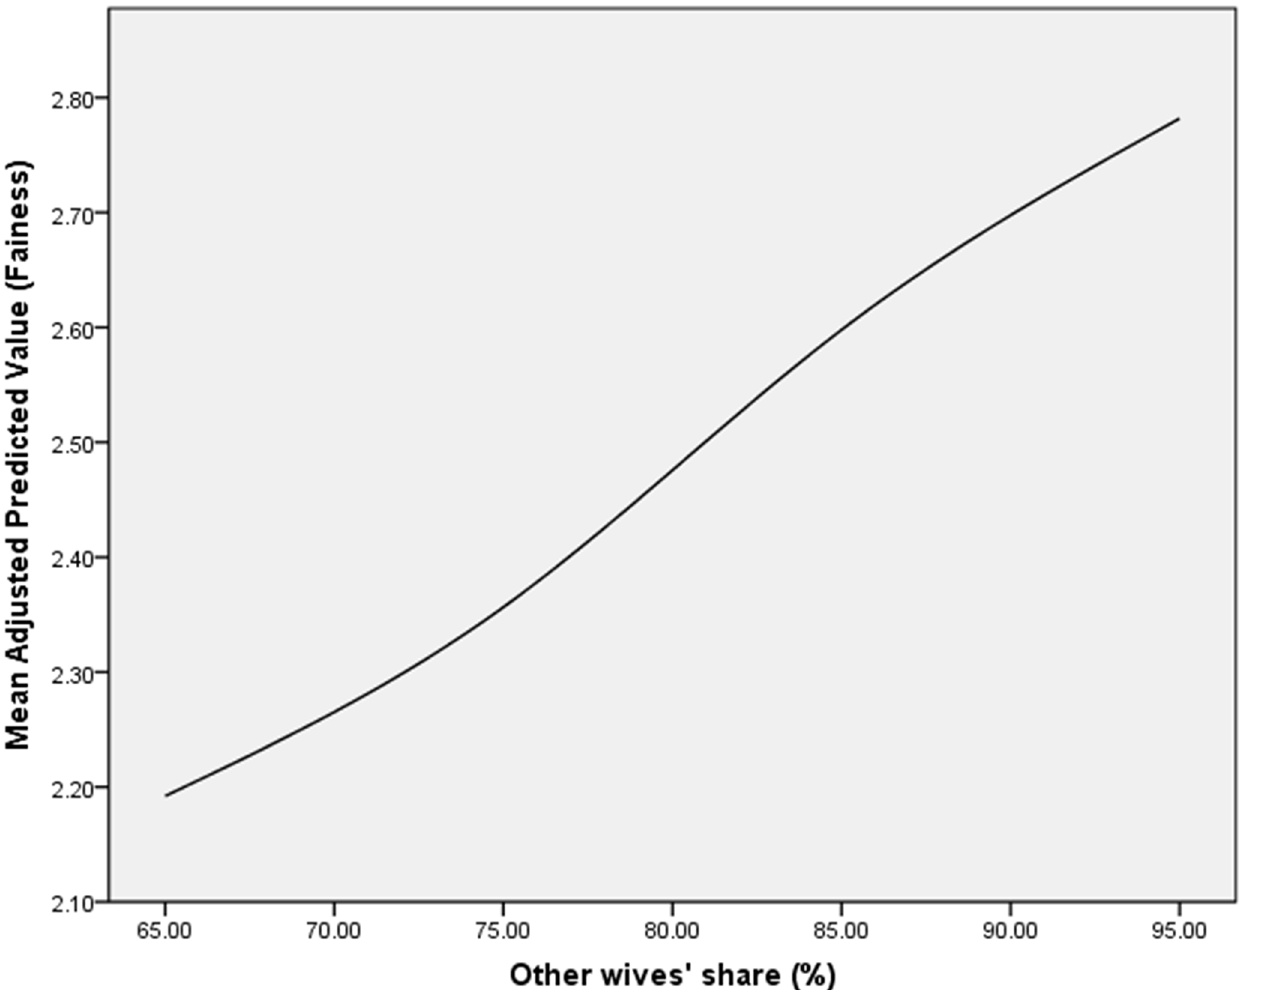
Fig 1. Perception of Other Wives ’ Share of HHC on Woman ’ s Perception of Fairness around